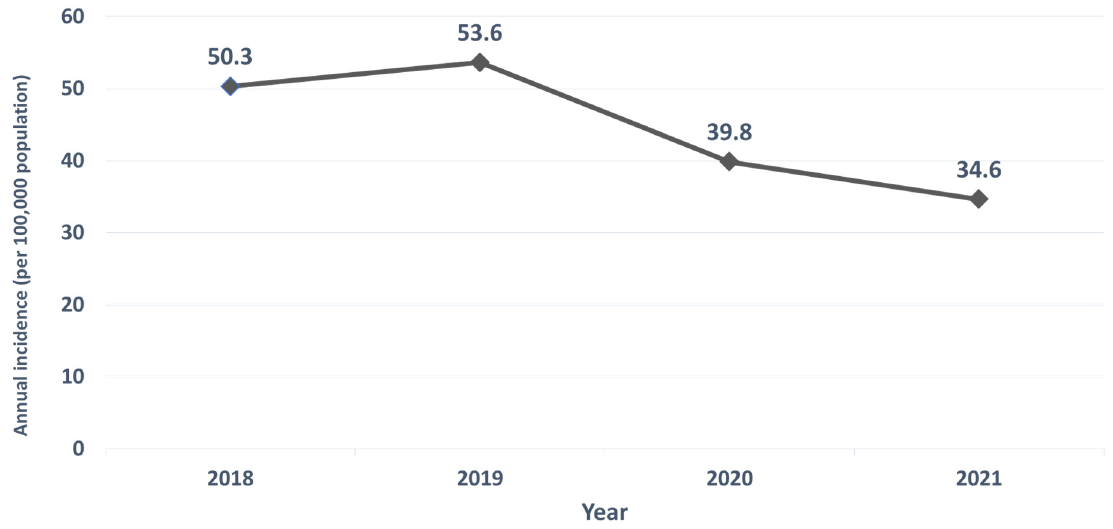
Figure 2. Annual incidence of airborne/droplet-transmitted notifiable infectious diseases between 2018 and 2021.